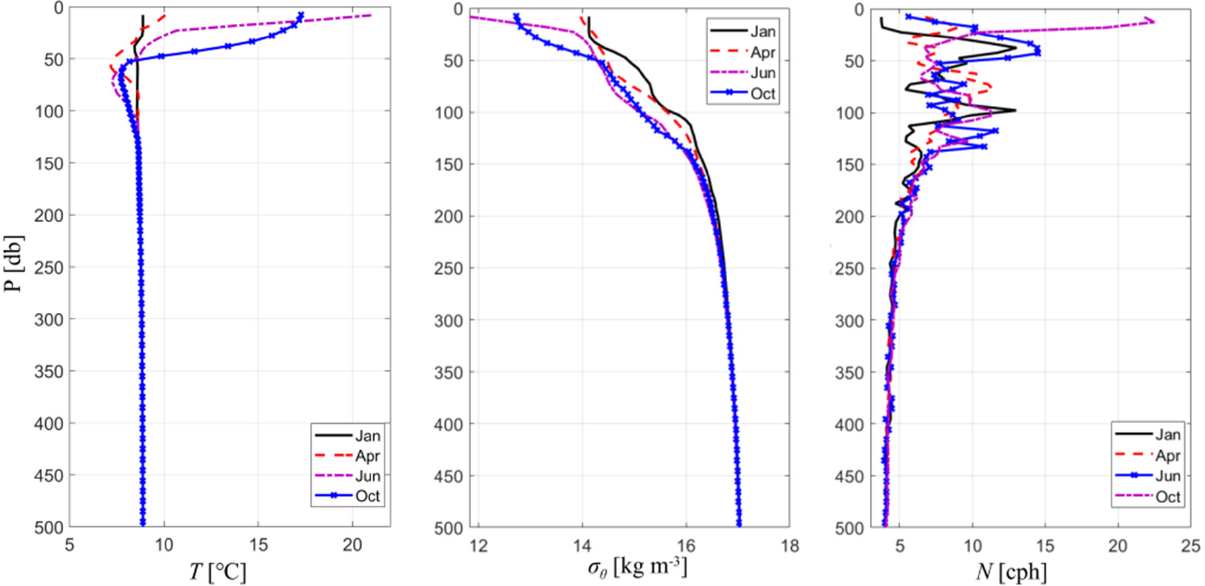
Figure 2. Vertical profiles of the temperature T , potential density σ θ , and the Brunt-Väisäla frequency N near to ABS No. 1 for 11 January, 13 April, 13 June, and 11 October 2017, based on data from Argo floats Nos. 6901832, 6901833, and 6901834. Profiles are given to a depth of 500 m to show the changes in the upper layer of the sea in more detail.